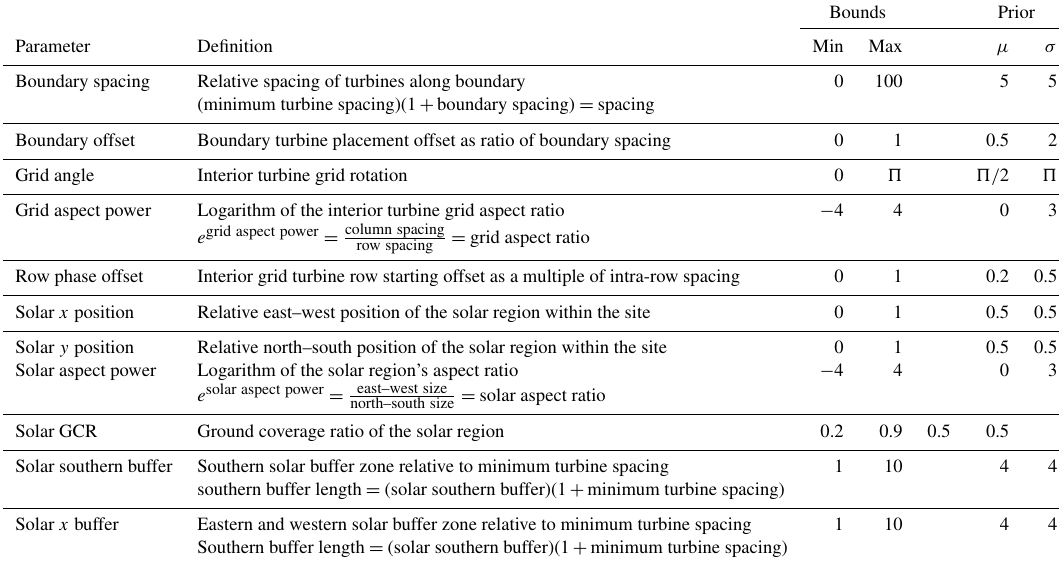
Table 1. Optimization variables used in our problem formulation.